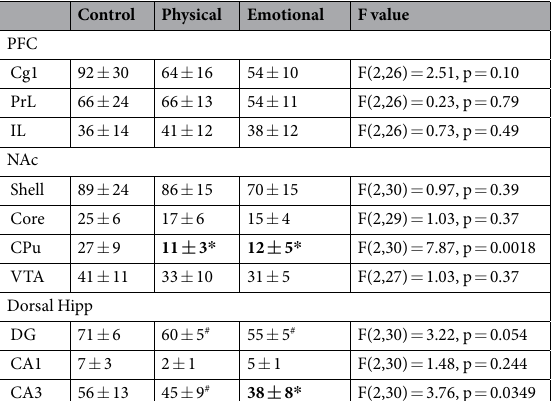
F(2,29) = 1.03, p = 0.37